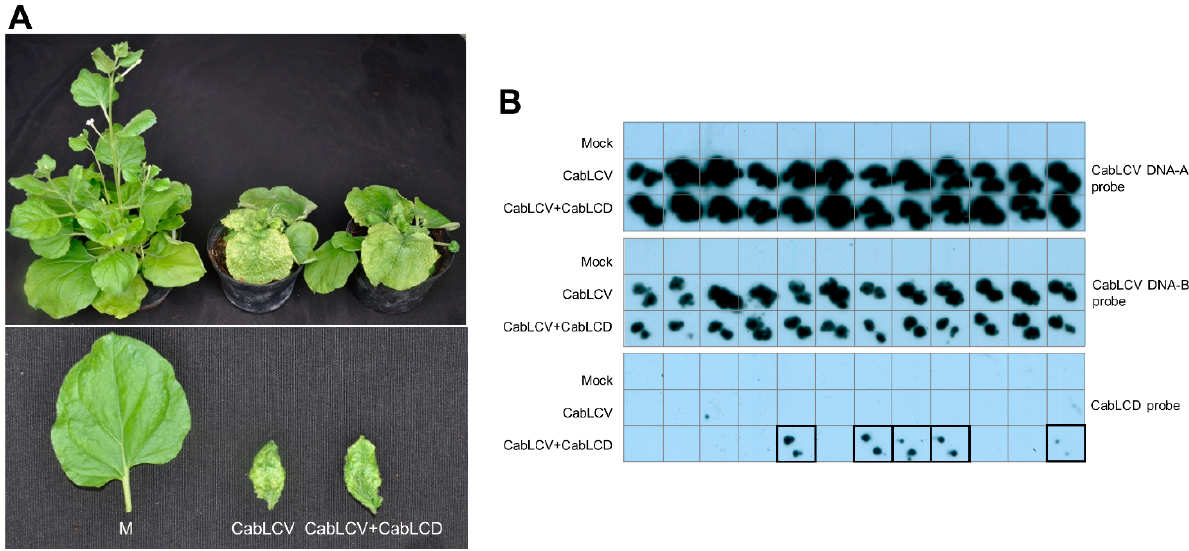
Figure 7. Agroinoculation experiments with cabbage leaf curl virus and cabbage leaf curl deltasatellite in Nicotiana benthamiana . ( A ) Symptoms caused by CabLCV and CabLCVD on agroinoculated N. benthamiana plants. Mock-inoculated controls (M) are shown on the left. ( B ) CabLCV (DNA-A and DNA-B) and CabLCD were detected by molecular hybridization after tissue printing on nylon membranes using specific digoxigenin-labelled DNA probes for each viral/subviral component. Prints of mock-inoculated plants were included as negative controls. Prints of CabLCD-infected plants are outlined. Table 2. Infectivity of cabbage leaf curl virus (CabLCV) and the associated cabbage leaf curl deltasatellite (CabLCD) in Nicotiana benthamiana plants.